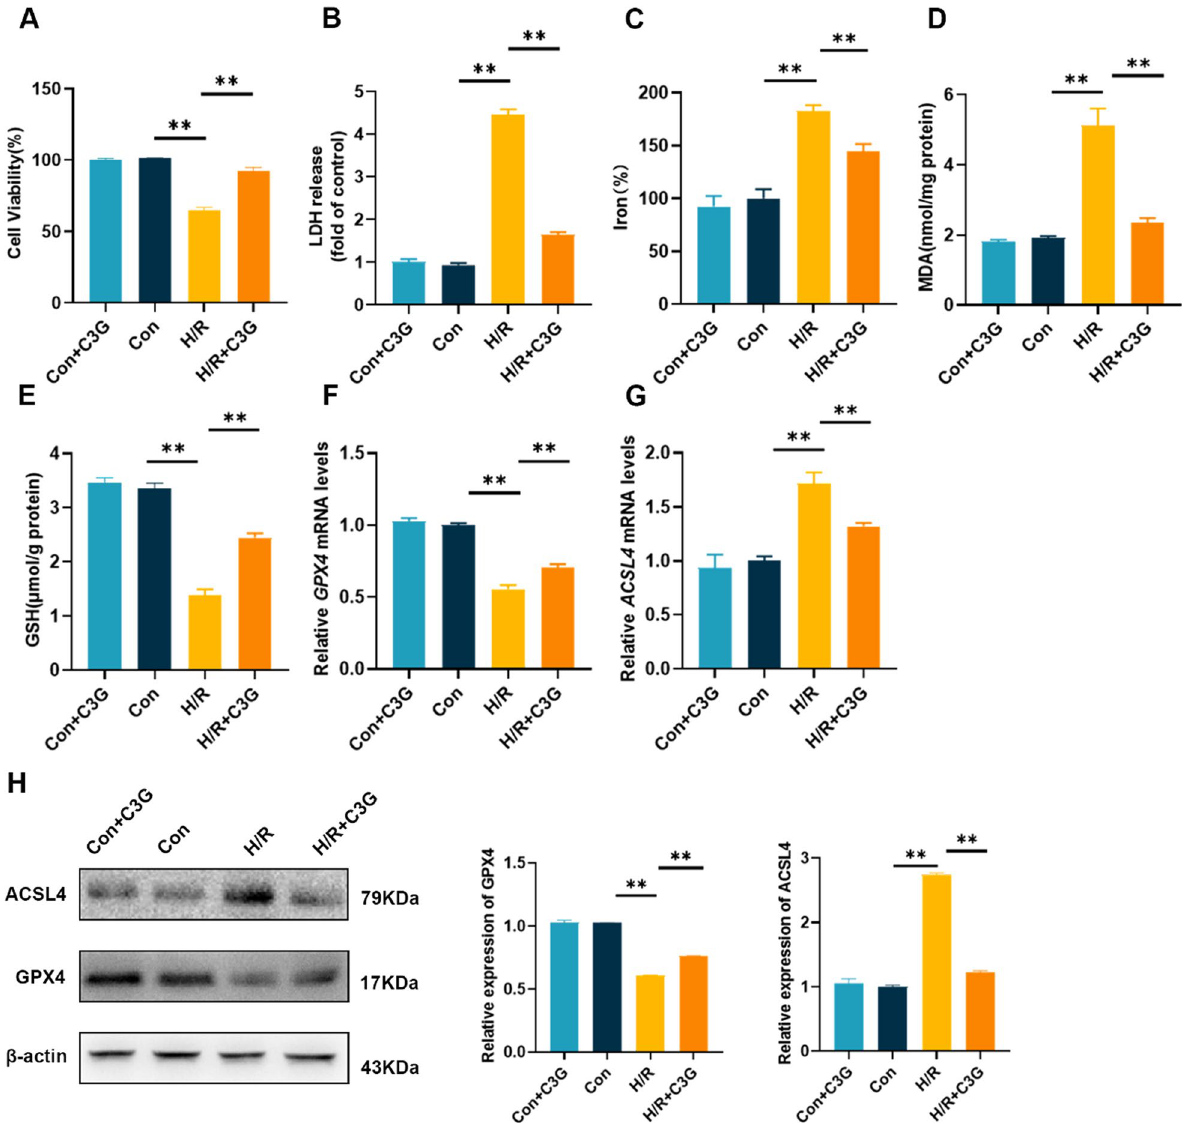
Fig. 2 The effect of C3G on H/R‑mediated ferroptosis in HK‑2 cells. A Cell viability determined by CCK‑8 cell viability assay. (n were exposed to hypoxia and reoxygenation (H/R); B LDH release was assessed by LDH assay kit in different groups. (n of iron, MDA and GSH of different groups in HK‑2 cells. (n 6); F , G RT‑PCR results of GPX4 and ACSL4 in HK‑2 cells. (n = results of GPX4 and ACSL4 in HK‑2 cells. (n 3). *p < 0.05, **p < 0.001. C3G cyanidin‑3‑glucoside, H/R hypoxia/reoxygenation, HK-2 human = proximal tubule epithelial cells, CCK-8 cell counting kit‑8, LDH lactate dehydrogenase, MDA malondialdehyde, GSH glutathione, RT-PCR reverse transcription polymerase chain reaction, GPX4 glutathione peroxidase 4, ACSL4 acyl‑CoA synthetase long chain family member